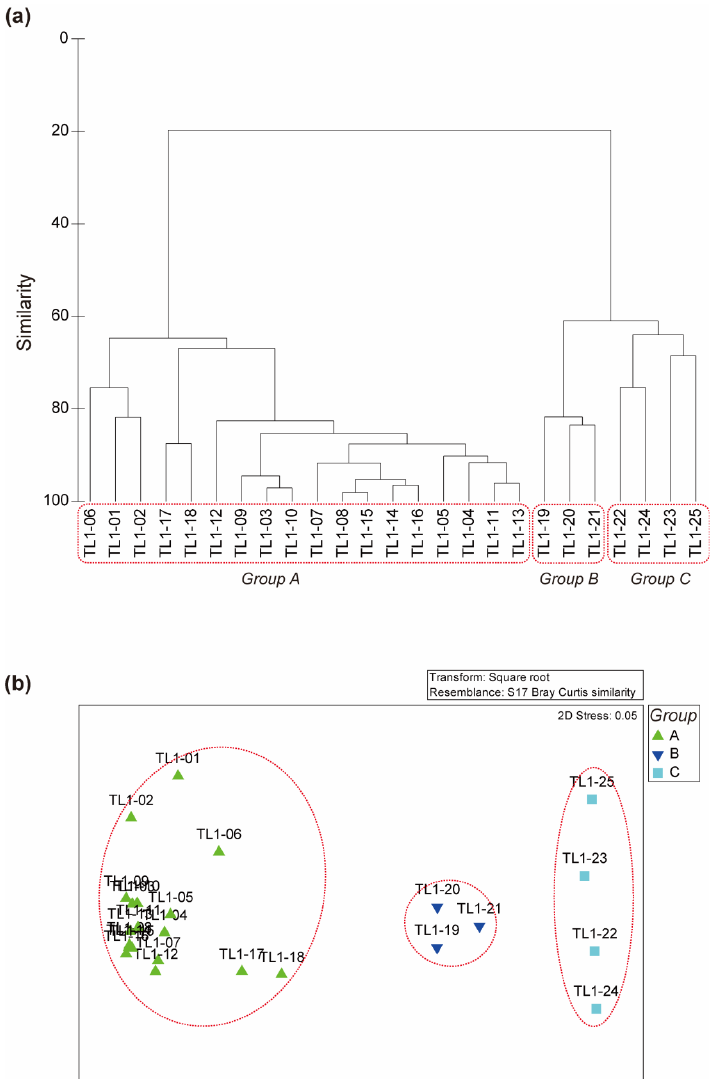
Figure 6. Multivariate analyses of the first transect line (TL-1). ( a ) Dendrogram of cluster analysis. ( b ) Non-metric multidimensional scaling ordination results. Analyses based on square root trans- formed coverage data of benthic habitat types as determined by digital imaging analysis of the 25 photo-quadrats (i.e., sampling points) along TL-1.